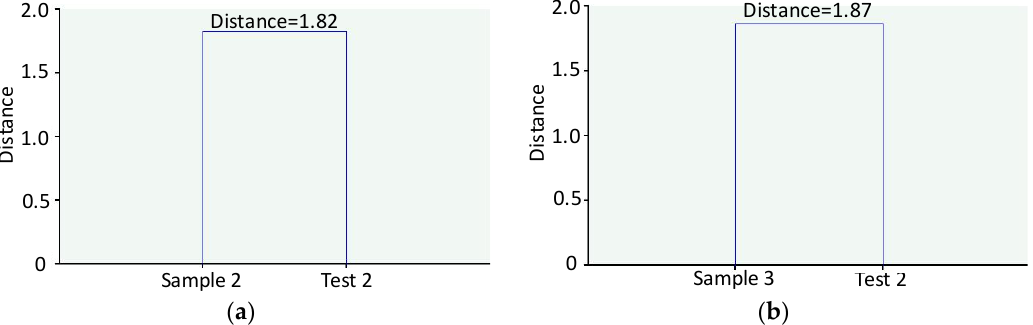
Figure 8. Results of the second clustering analysis carried out for Test 2 showing the distances between: ( a ) Test 2 and Sample 2; ( b ) Test 2 and Sample 3.